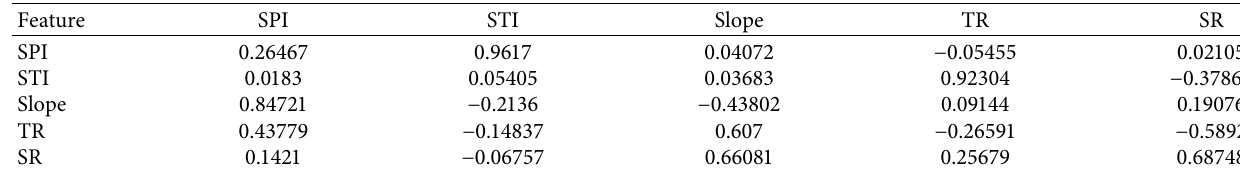
Table 6: Eigenvectors of all principal